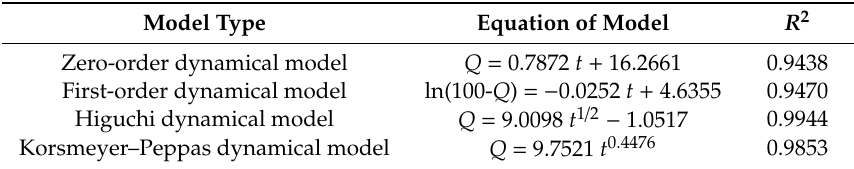
Table 4. The fitting results of the release profile of composite microcapsules.